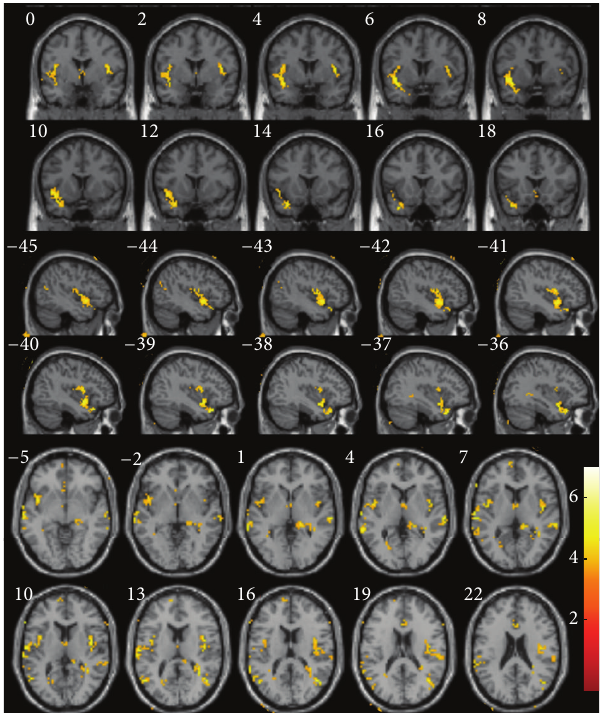
Figure 2: Voxel-based morphometry results showing regions posi- tively correlated with composite free-recall verbal memory (yellow, uncorrected 𝑃 < 0.001 ).